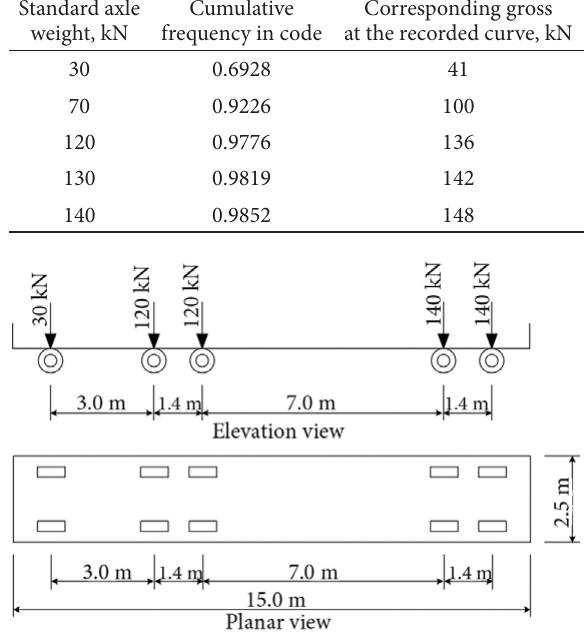
Fig. 12. Vehicle model proposed by Chinese code